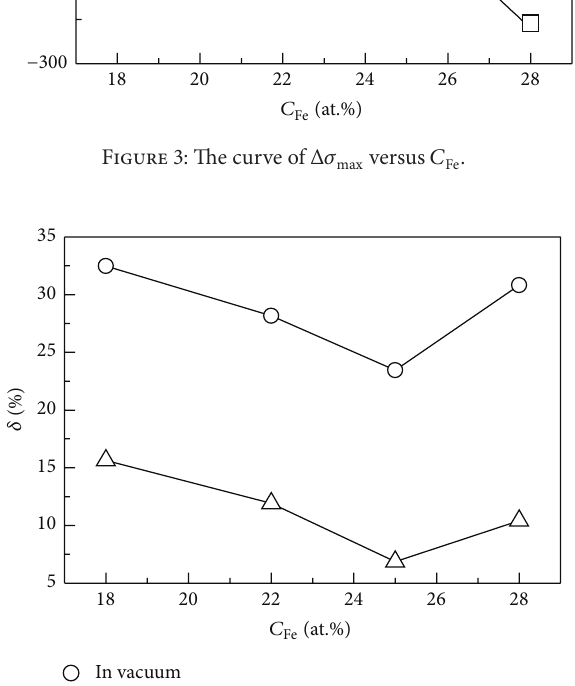
Figure 4: The change of elongation of the ordered Ni 3 Fe with Fe stoichiometry when testing in vacuum and in H 2